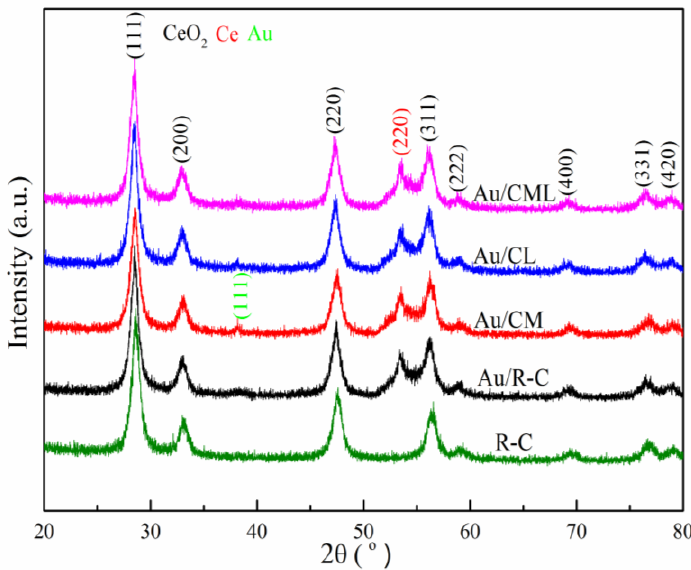
Figure 1. XRD patterns of the catalysts. Table 1. Physical and structural properties of the